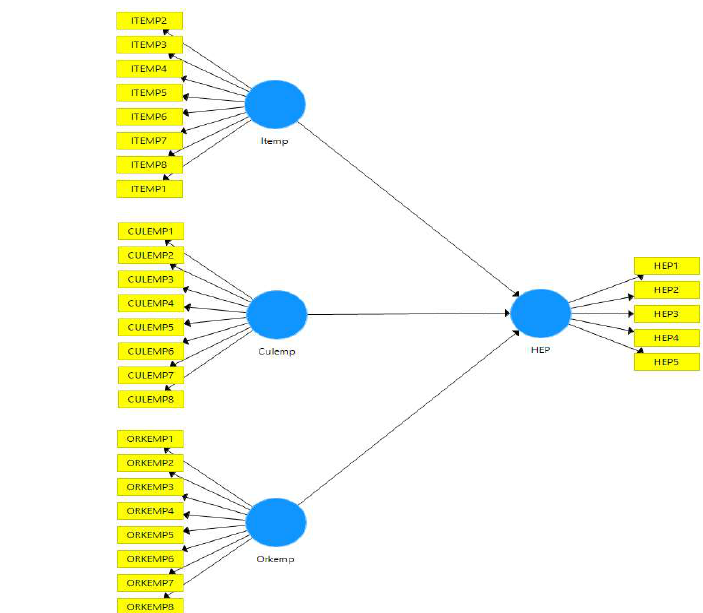
Fig. 2. Structural Model of the